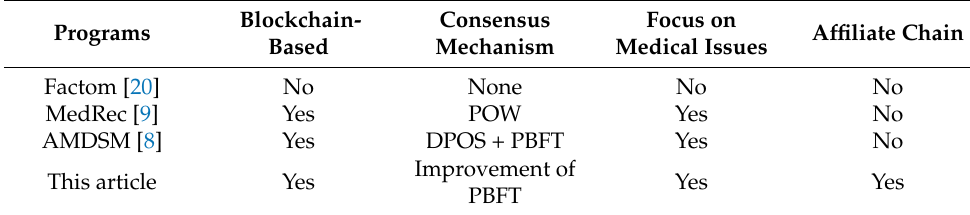
Table 1. Scheme comparison.